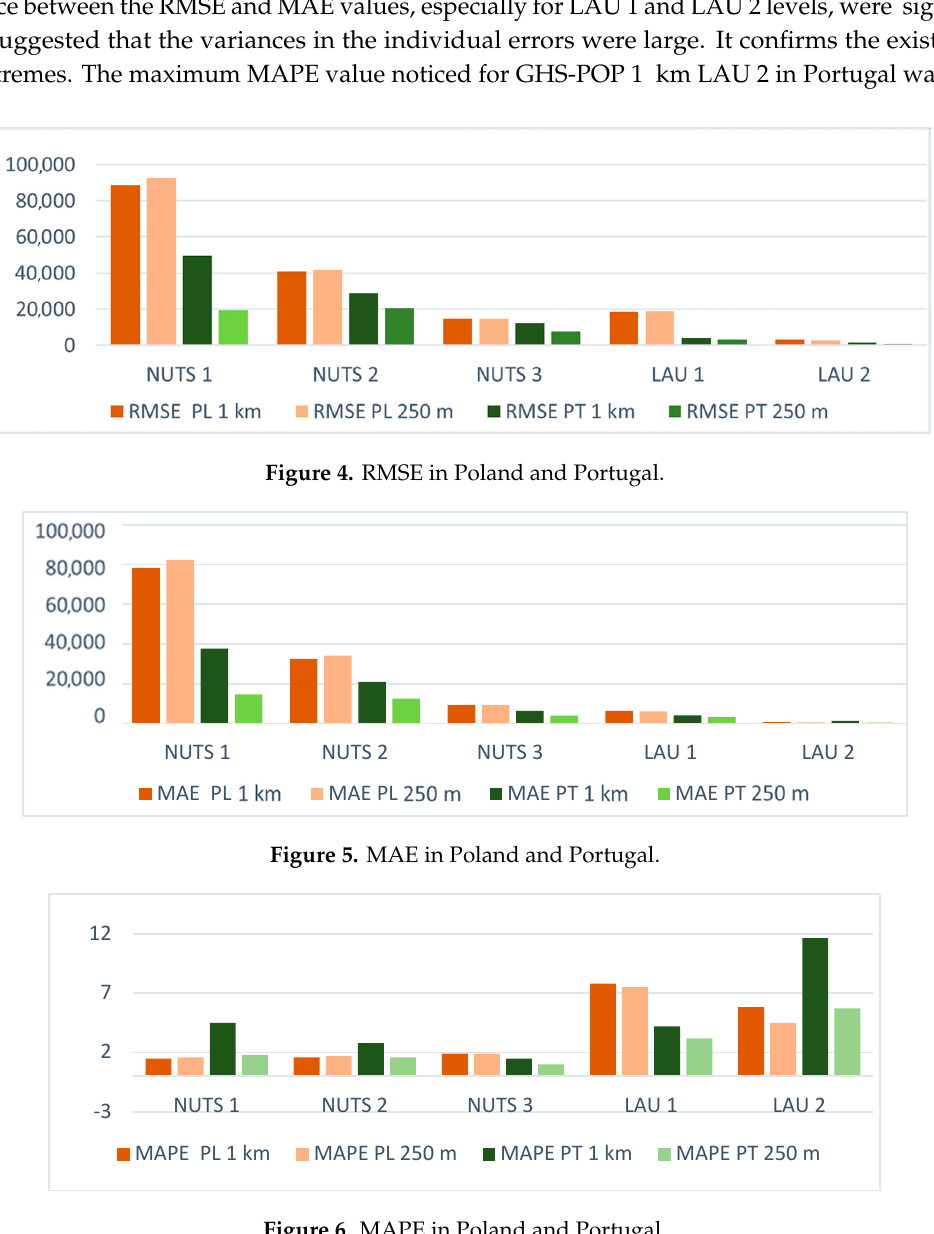
Figure 6. MAPE in Poland and Portugal.